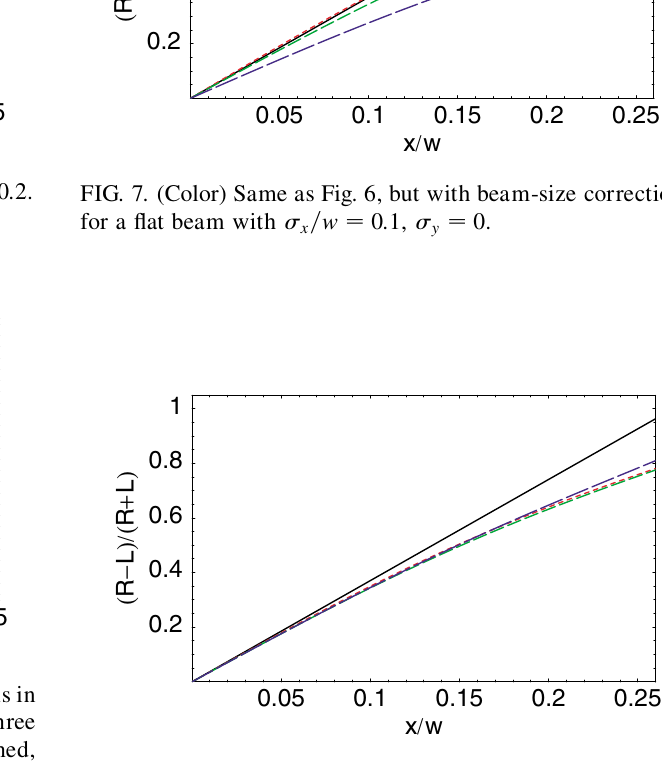
(cid:3) 0 , (cid:7) =h (cid:3) 0 : 1 . x y